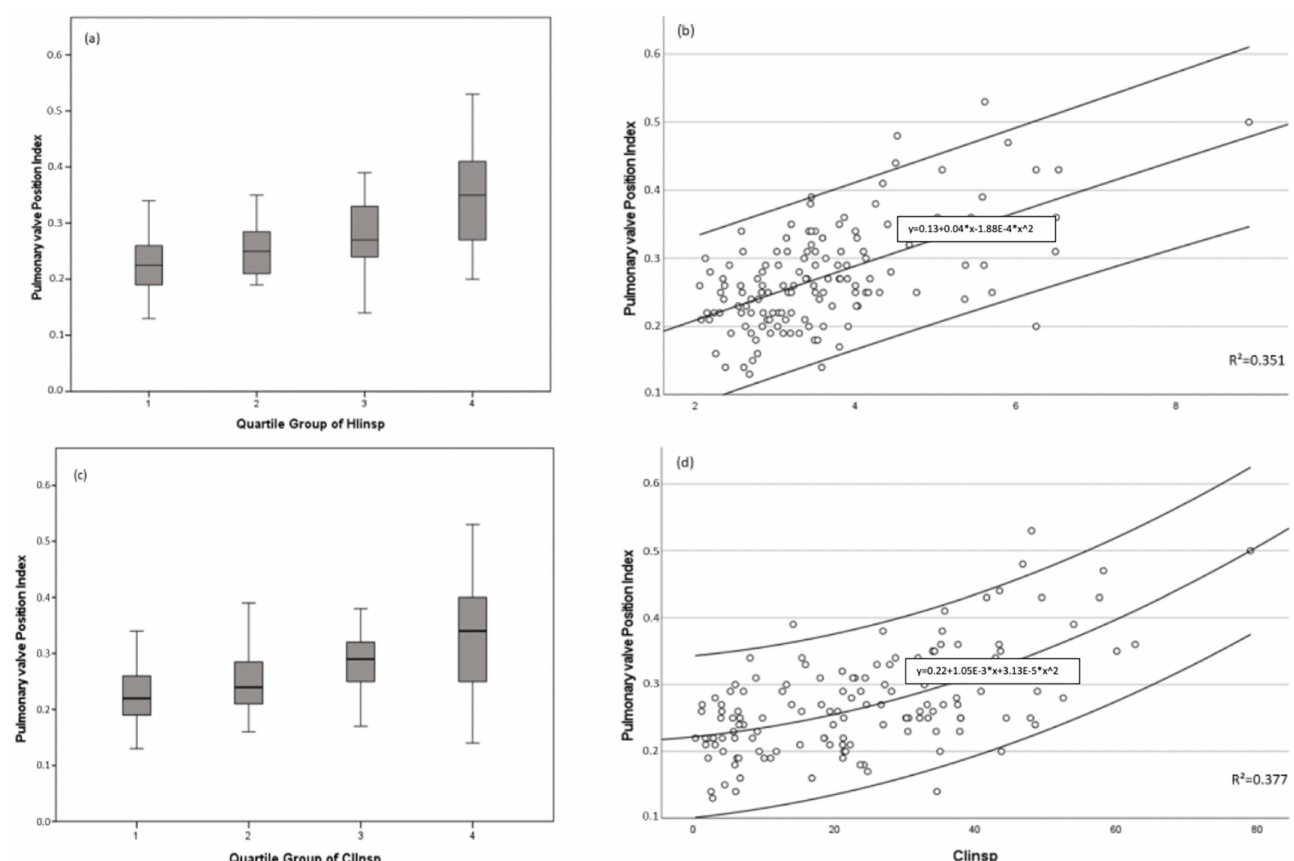
Figure 3. Indexed pulmonary valve position in relation to quartiles of HIinsp and CIinsp. ( a , b ) depict the distribution of indexed pulmonary valve position according to HI insp ; ( c , d ) show the distribution of indexed pulmonary valve position according to CI insp.